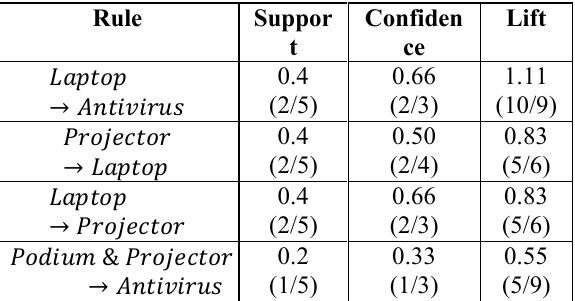
Table 2: Association Rule Framing